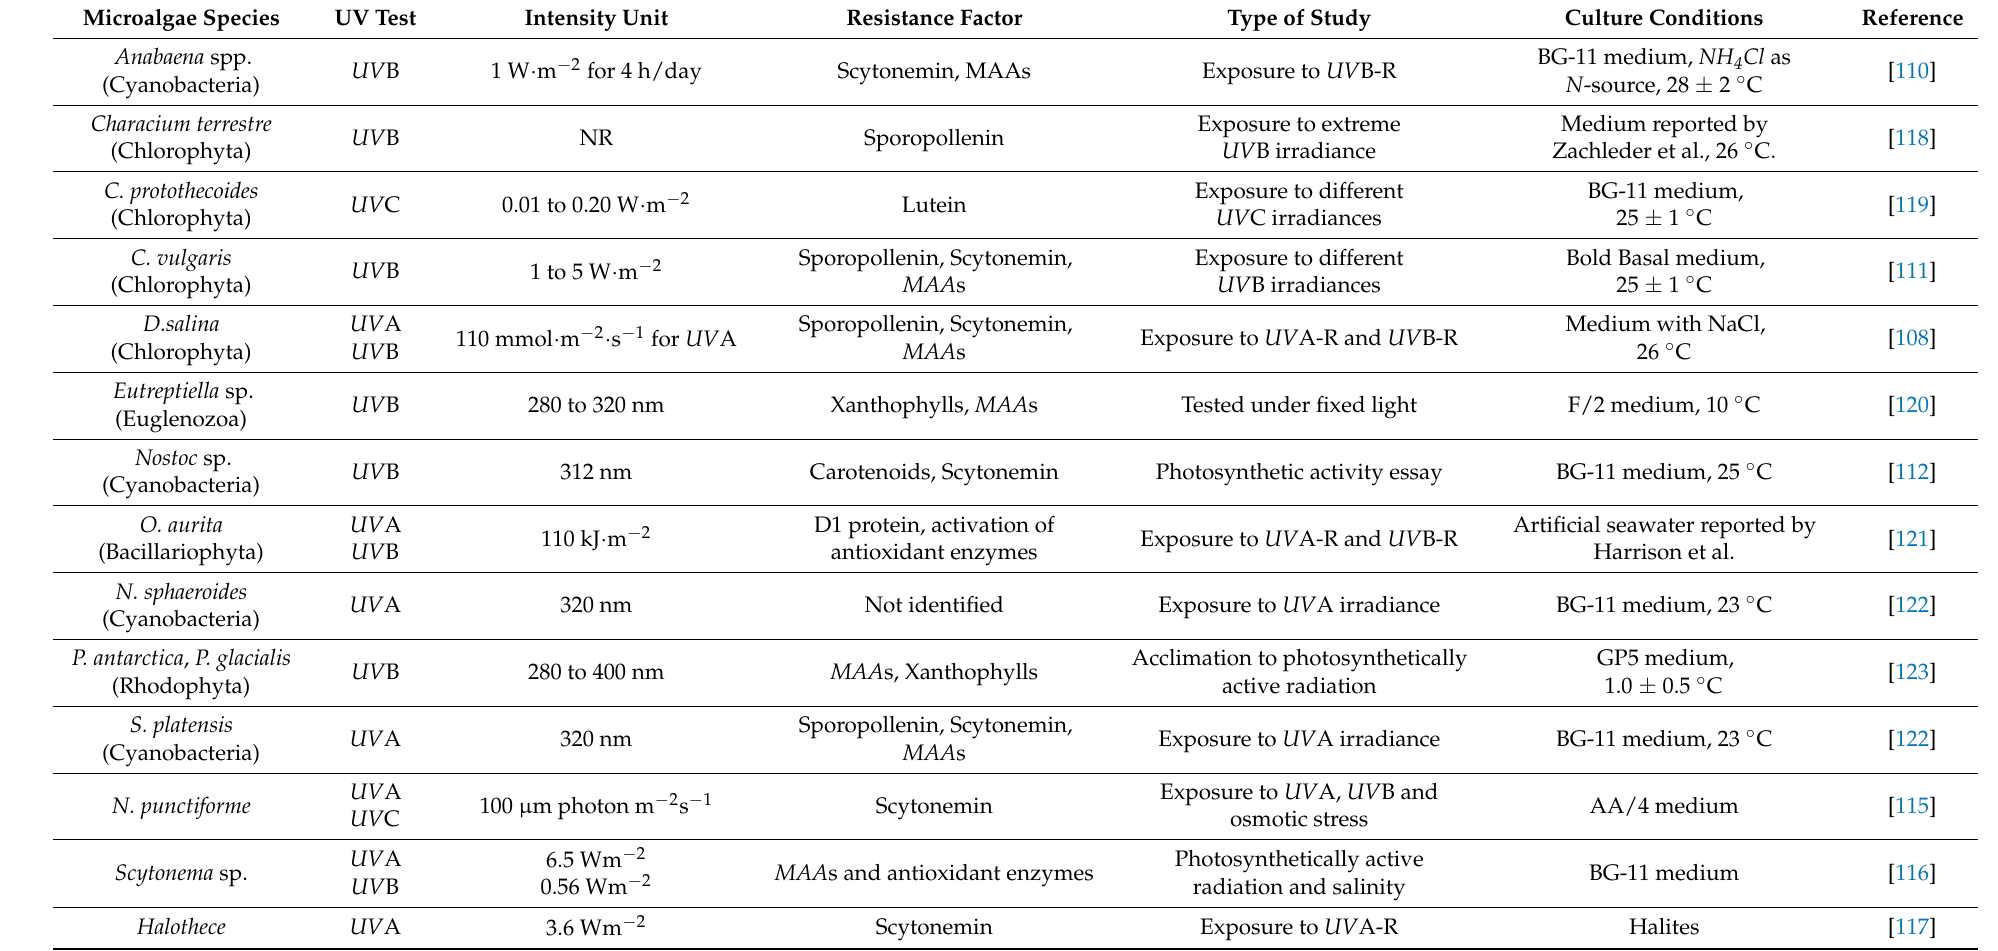
Table 3. List of different microalgae with photoprotection